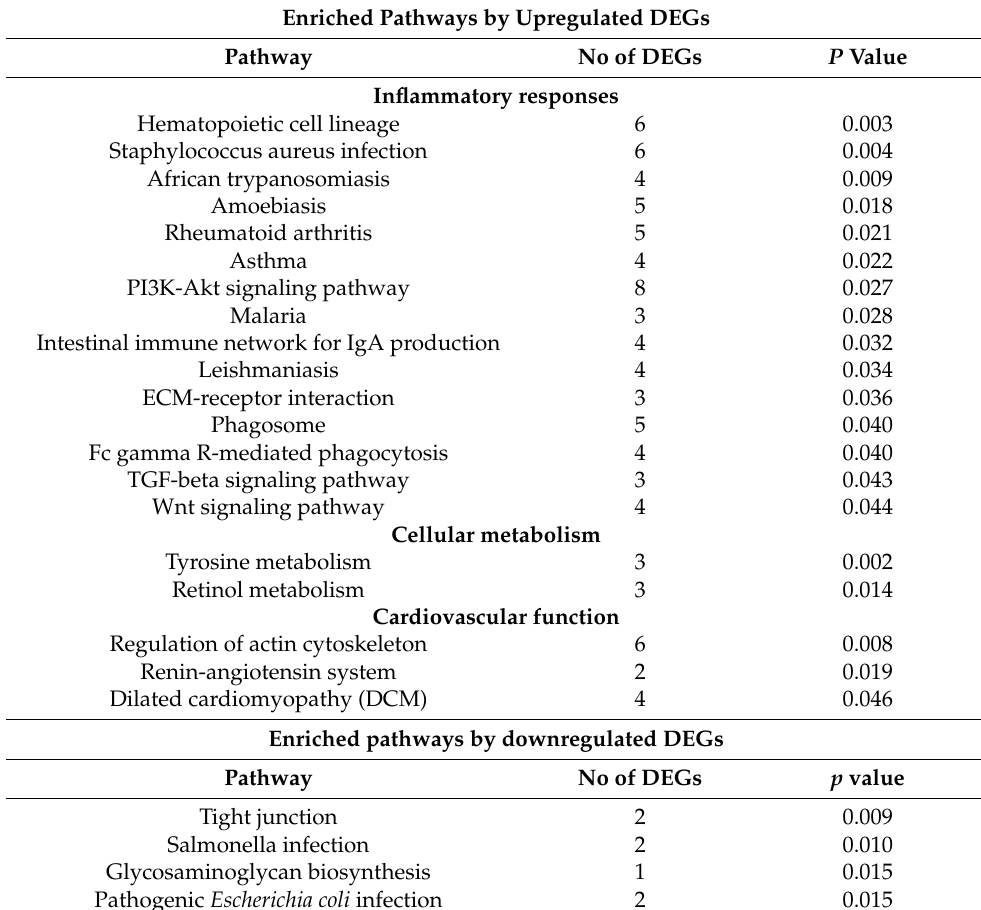
Table A5. KEGG enriched pathway (Self-control vs.